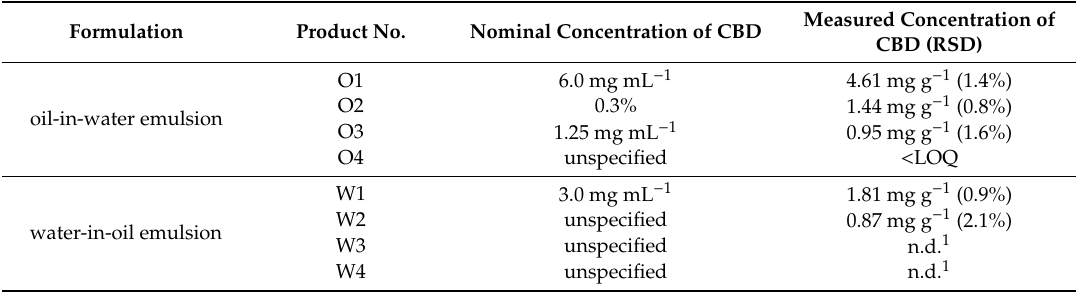
Figure 5. Chromatogram of an analysis of one real-world sample with an oil-in-water emulsion. Table 4. Results of real-world samples.